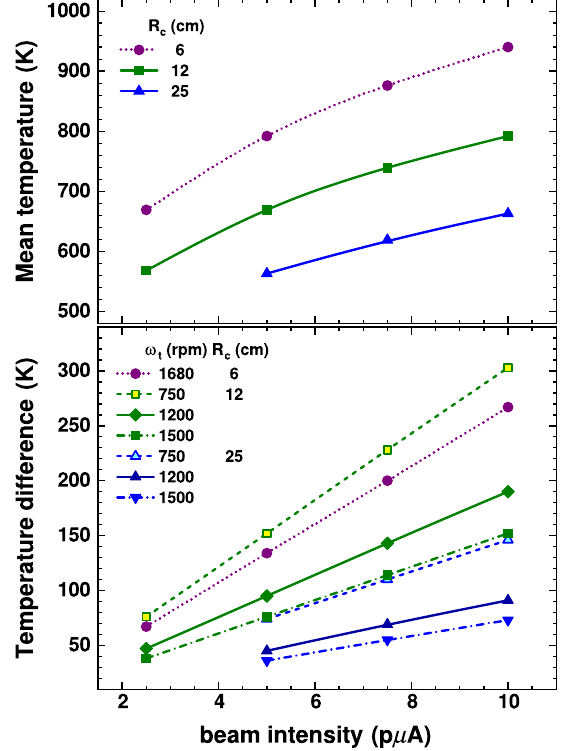
FIG. 10. Mean temperatures and differences between maximal and minimal temperatures as a function of 48 Ca beam intensity for rotating target wheels with different central radii R c and angular velocities ω